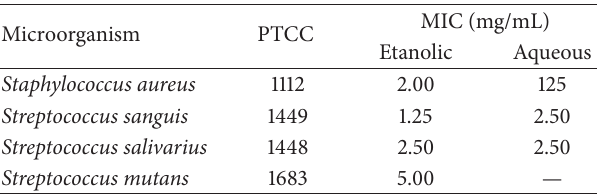
Table3:MICvaluesofetanolicandaqueousextractsofjuglansregia bark against oral Bacteria.